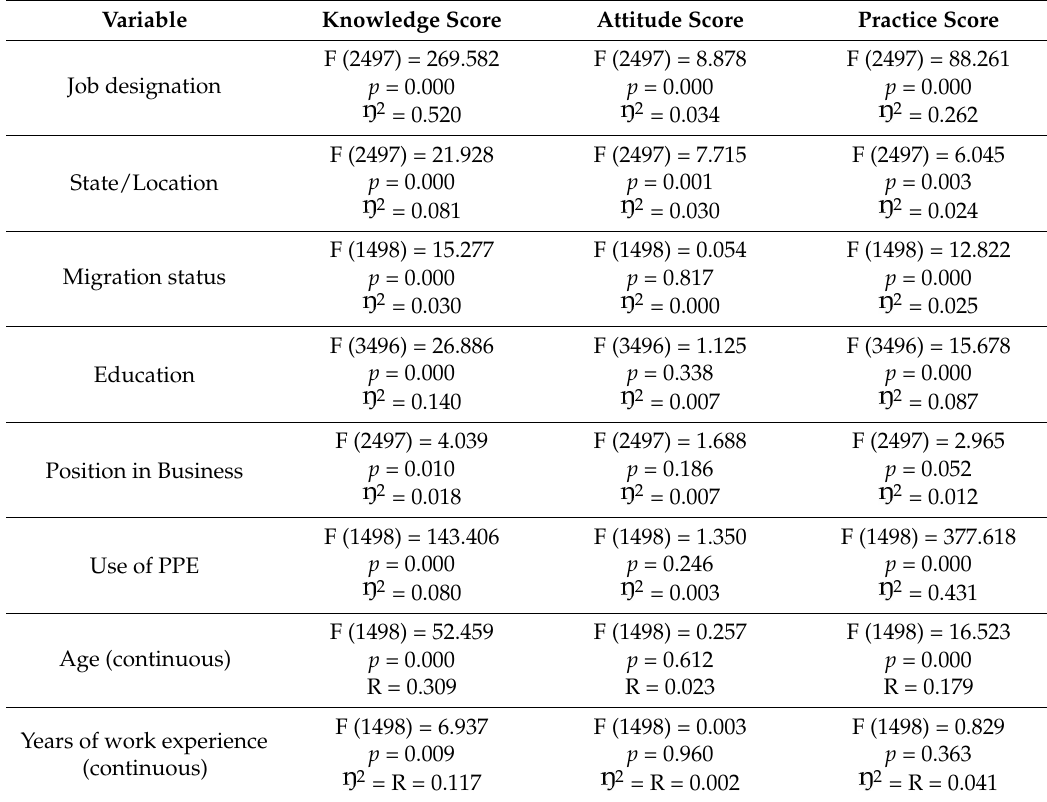
Table 2. One-Way ANOVA output for the Knowledge, Attitude, and Practice scores on a 1–10 point scale.